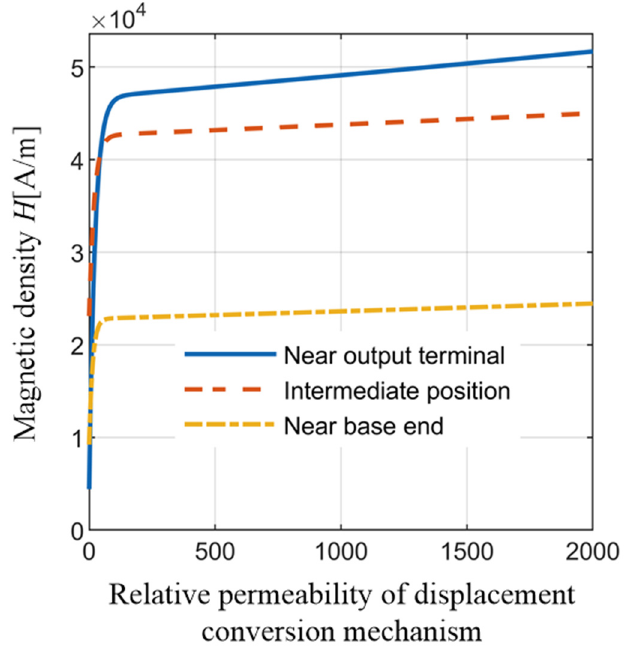
Figure 14. Changes in the magnetic density of the GMM cylinder by changing the relative permea- bility of the shell.